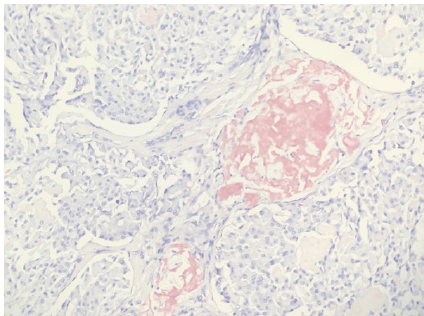
Figure 1: Amyloid accumulation was seen as a pink coloured amorphous material in this section which is typical for medullary thyroid cancer on Congo Red staining. (20X).